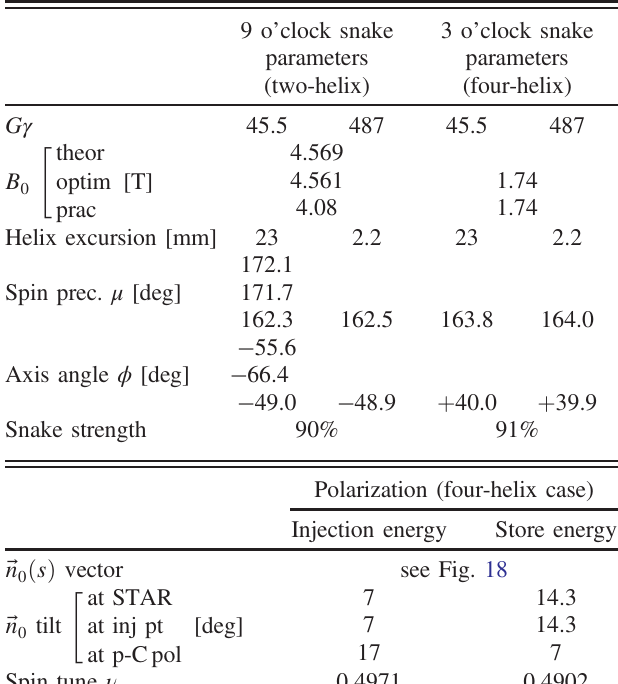
TABLE IV. Required field setting in 9 o ’ clock two-helix snake (columns 2, 3) and in 3 o ’ clock outer helices (columns 4, 5), resulting helix excursion, snake angles μ , ϕ , snake strength, spin closed orbit ⃗ n 0 ð s Þ , and spin tune ν , in three different approaches sp at injection energy ( G γ ¼ 45 . 5 ), namely, “ theor. ” : a closest approach to Eq. (8), yielding μ [Eq. (9)] and ϕ [Eq. (10)] and, for comparison, “ optim. ” : optimized field value using field maps; “ prac. ” : actual RHIC operation parameter values. Columns 3 and 5 list parameter values when energy is set to 255 GeV ( G γ ¼ 487 ) which changes helix excursion in snakes. The ⃗ n 0 vector around RHIC, its tilt to vertical at injection point ( “ inj. pt ” ), STAR detector and p-C polarimeter, as well as spin tune ν , are for the sp four-helix